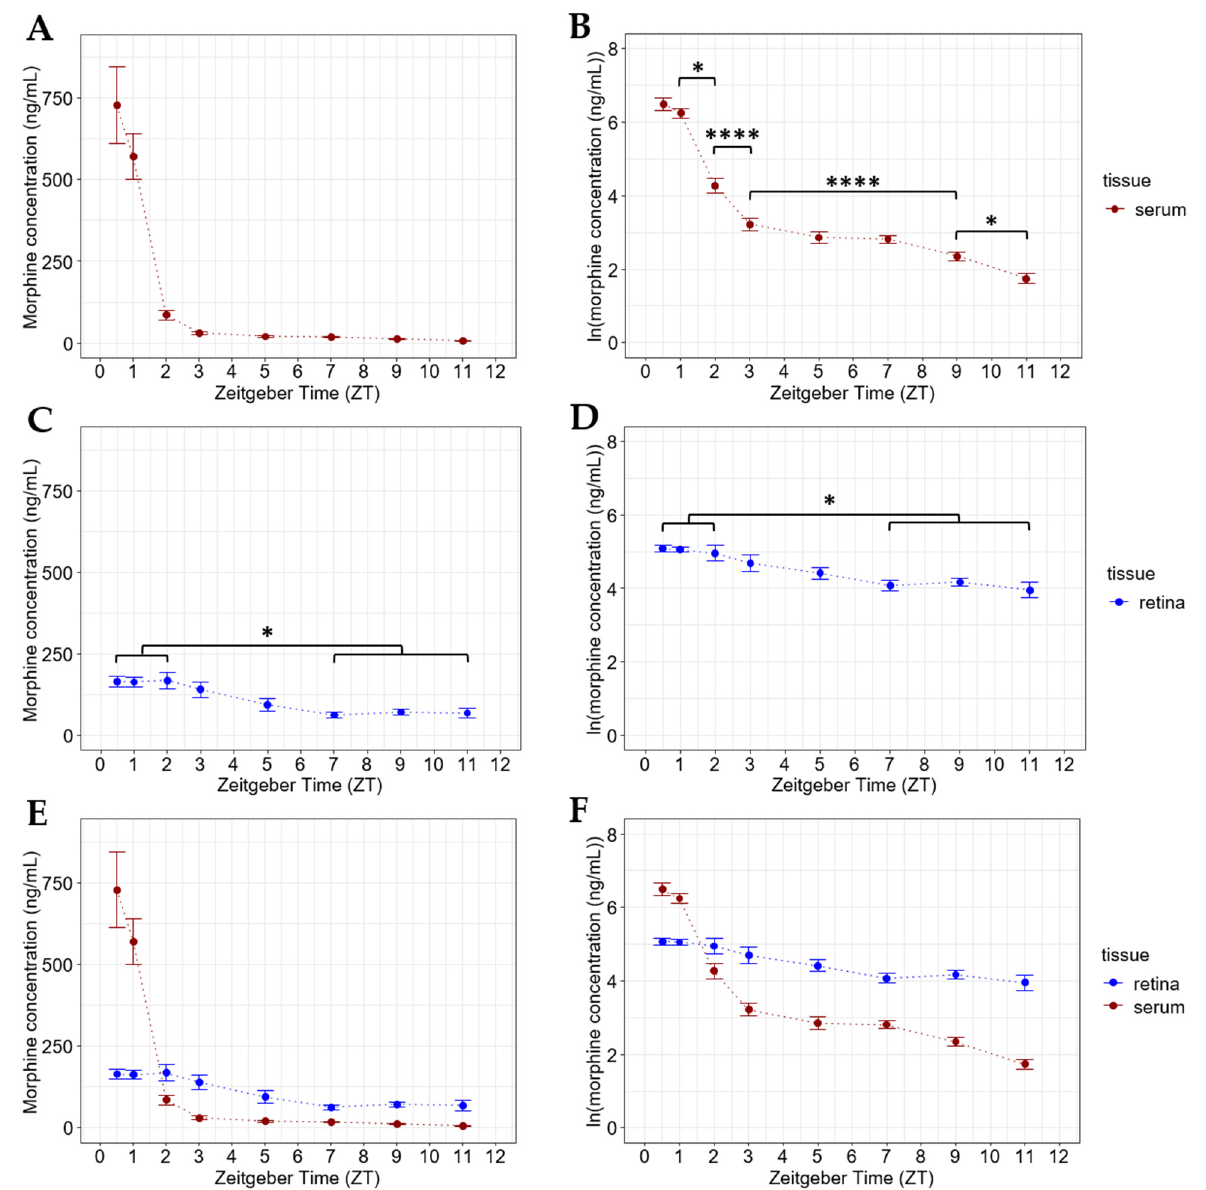
Figure 1. Morphine deposits in the retina following systemic exposure. ( A ) Serum morphine concentrations and ( B ) natural logarithmic (ln) transformation of serum morphine concentrations collected from mice sacrificed at specified time points following a 20 mg/kg i.p. morphine injection at light onset (ZT 0). One-way ANOVA with a Tukey post hoc adjustment was performed on an ln scale to compare serum concentrations from animals sacrificed at different time points (* = p < 0.05, **** = p < 0.0001). ( C ) Retinal morphine concentration and ( D ) ln transformation of retinal morphine collected from the same mice (as in A and B ) sacrificed at specified time points following a 20 mg/kg i.p. morphine injection at light onset (ZT 0). One-way ANOVA with a Tukey post hoc adjustment was performed on an ln scale (* = p < 0.05). ( E ) Serum and retinal morphine concentrations and ( F ) ln transform of serum and retinal morphine concentrations collected from mice sacrificed at speci- fied time points following a 20 mg/kg i.p. morphine injection at light onset (ZT 0). Retina and serum samples were collected from the same mice (as in A – D ) within each measured time point. ( F ) Sig- nificant differences exist within each plotted time point between the retinal and serum concentra- tions ( p < 0.001). Two-way ANOVA with a tissue x ZT interaction and a Tukey post hoc adjustment was performed on an ln scale. Data are presented as the mean ± SEM, with 8–16 mice per group.